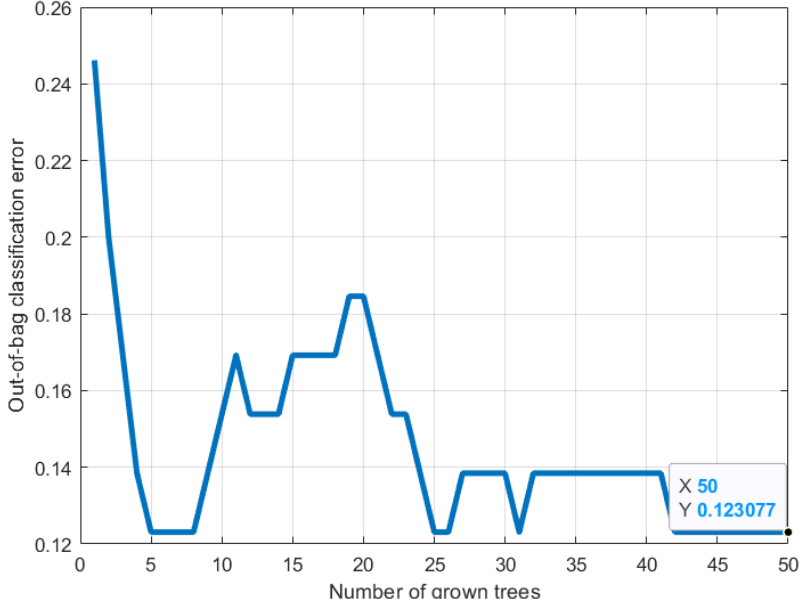
Figure 4. Random forest classification error minimization across the growing trees during training. RF optimizes its performance across several growing trees (e.g., 50 trees) by performing out-of-bag (OBD) error calculation.